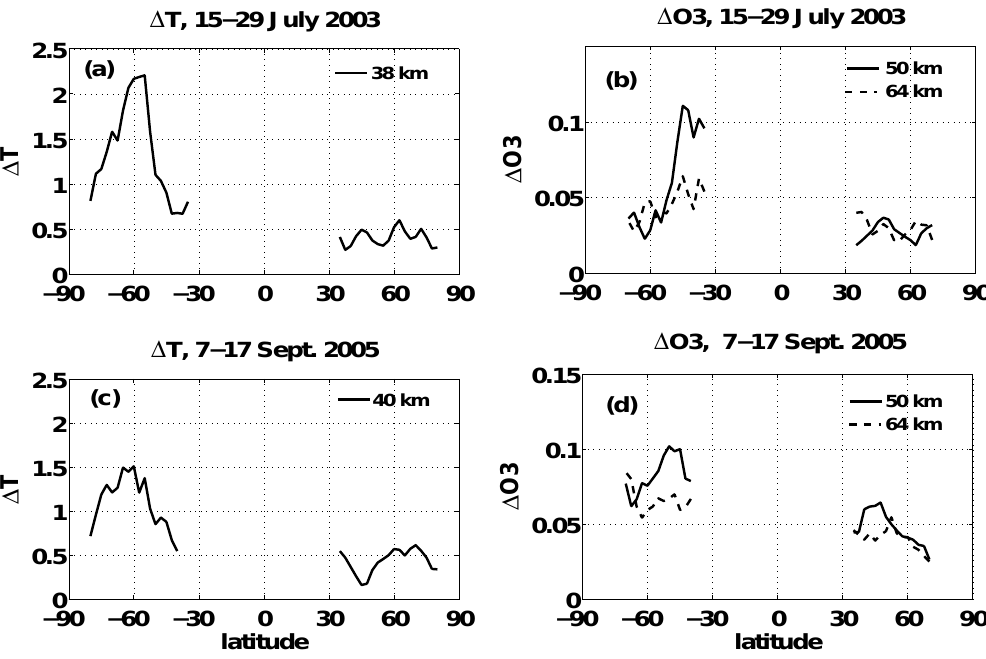
Fig. 1. Mean amplitude of the 5-day planetary wave as a function of latitude from measurements by Odin over the period 15–29 July, days 196–210, 2003 (a, b) and 7–17 September, days 250–260, 2005 (c, d) . Left hand panels are for the wave in temperature (K) at 38km (a) and 40km (c), right hand panels are for the wave in ozone (ppmv) at 50km (solid line) and 64km (dashed